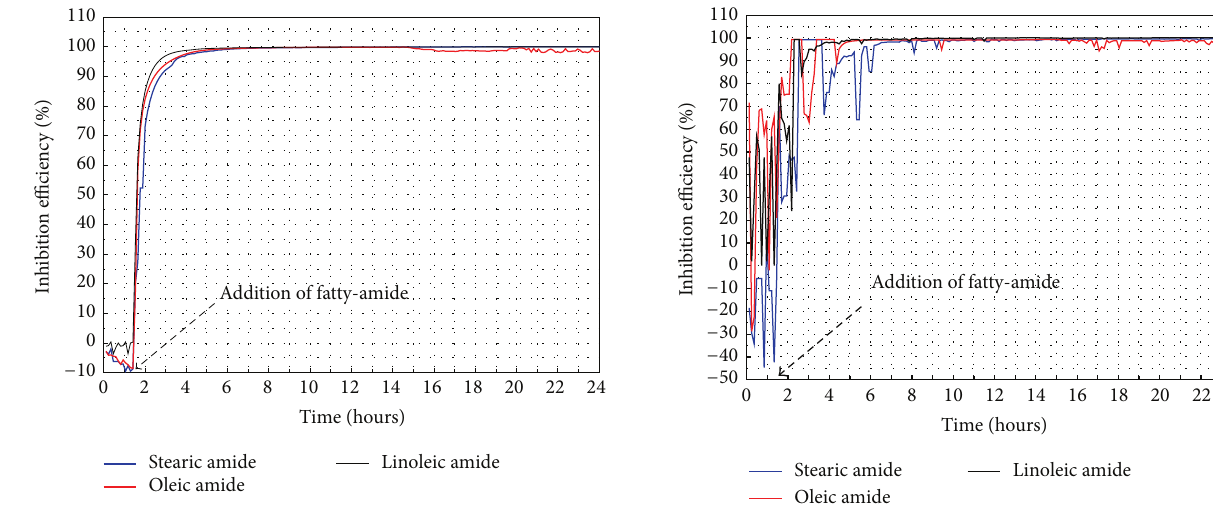
Figure 17: Variations of inhibition efficiency as determined by HDA measurements ( monitoring real-time